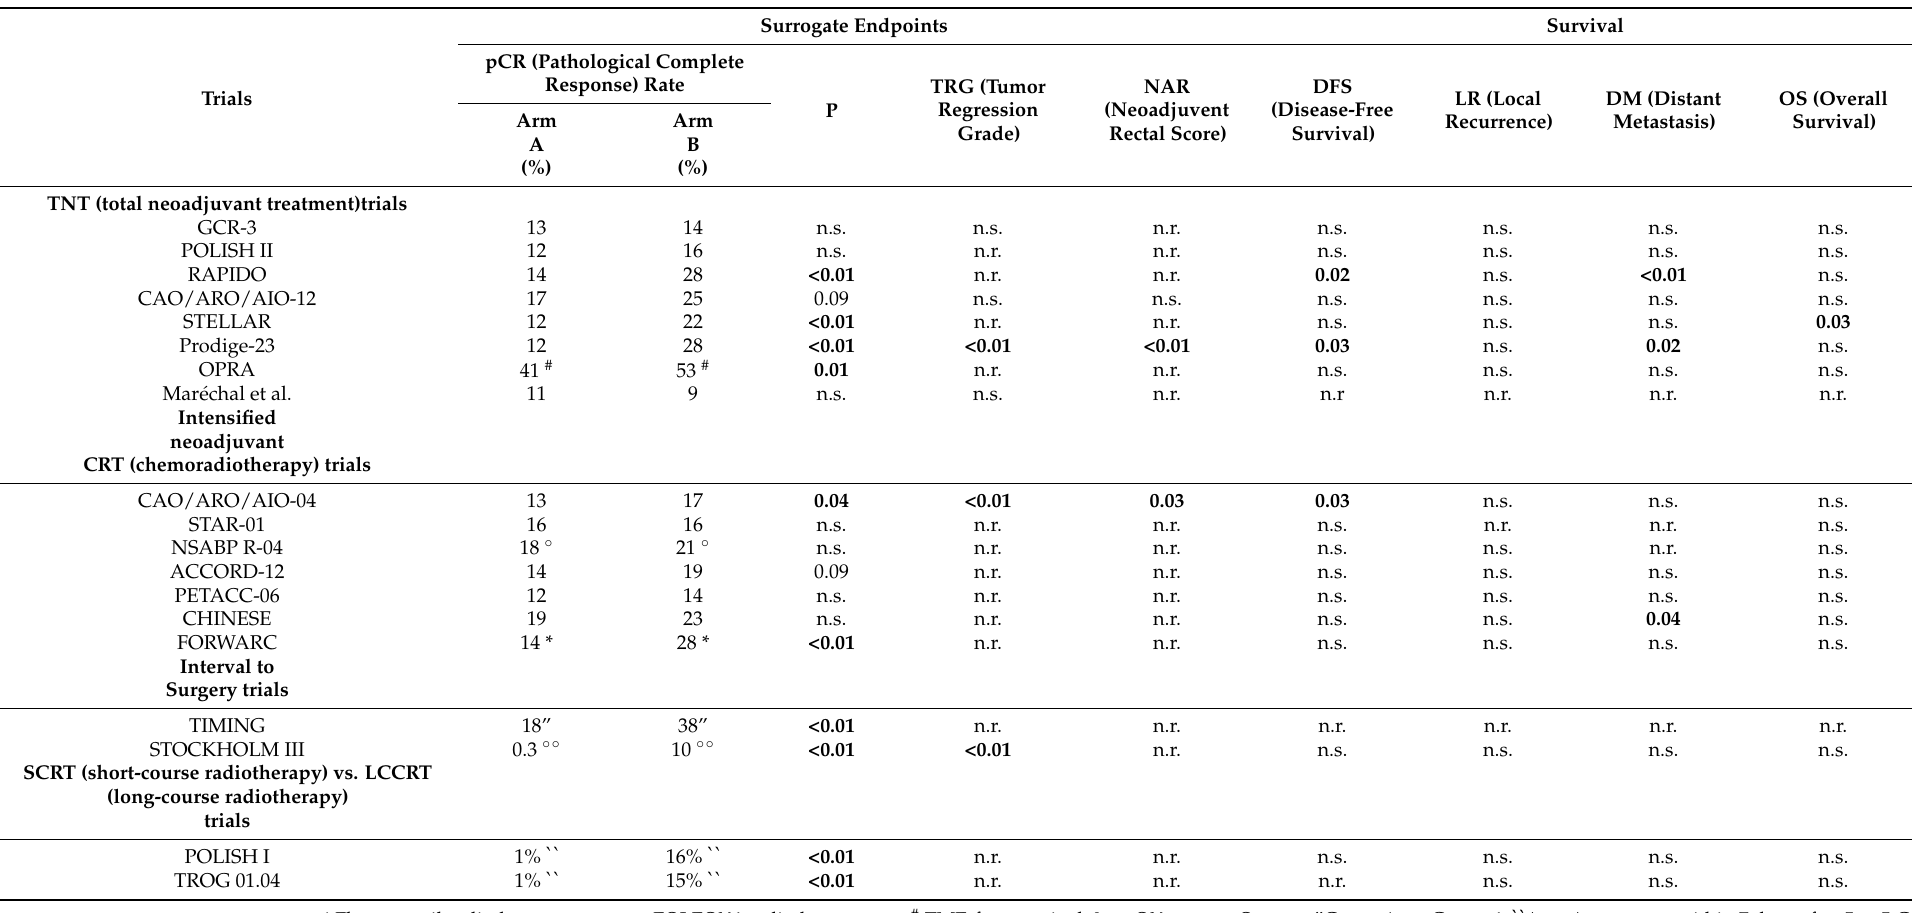
Table 4. Association between reported surrogate endpoints (pCR, TRG and NAR score) and survival in major prospective rectal cancer trials.